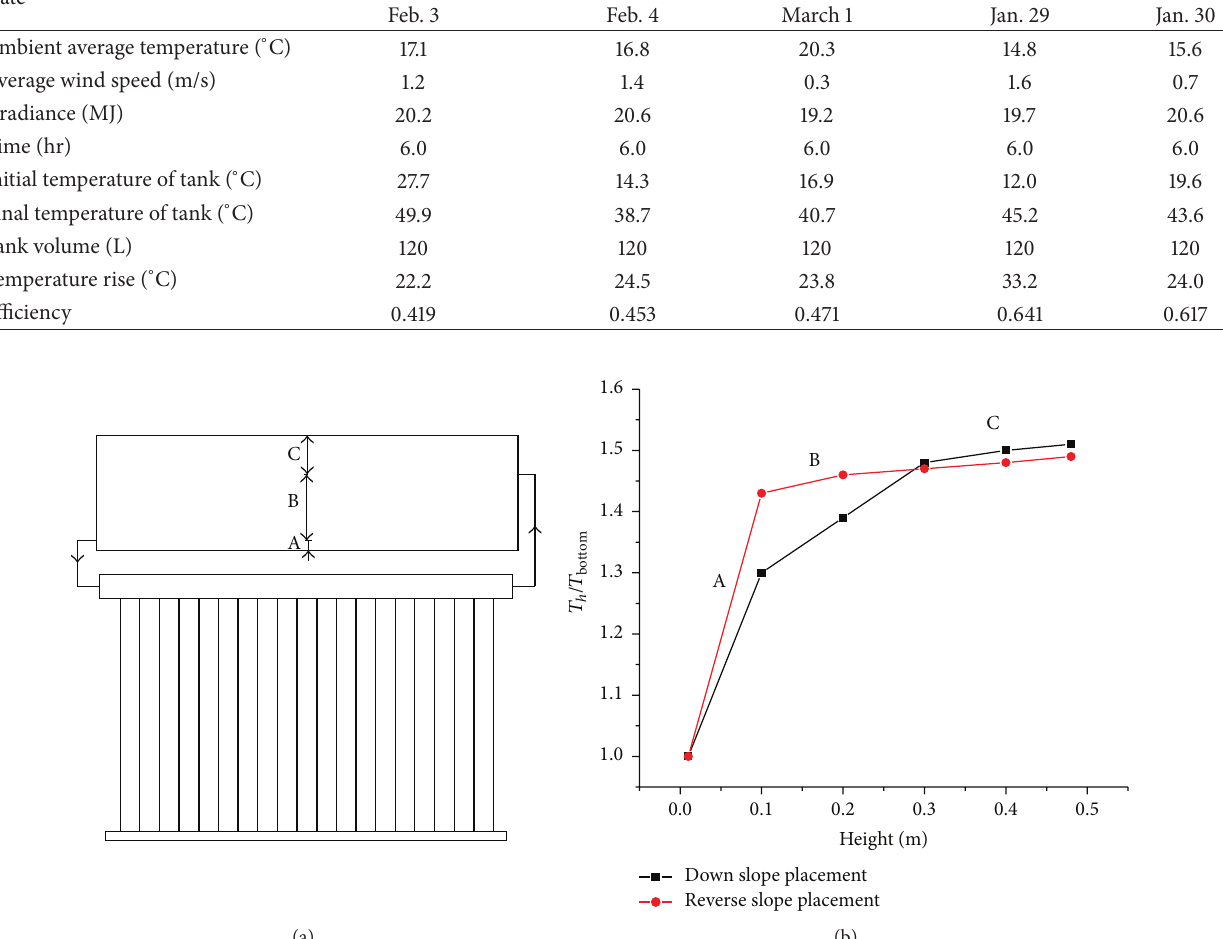
Figure 6: Temperature-based water stratification in water tank for collectors at down slope placement and at reverse slope